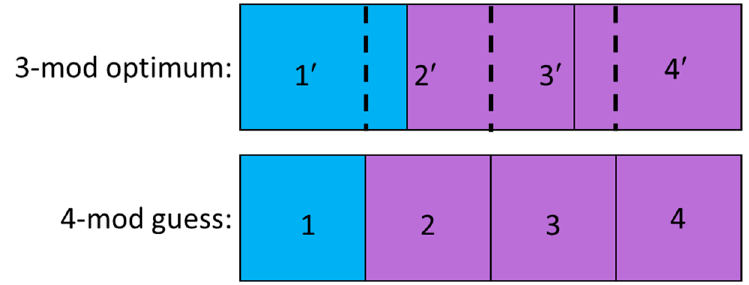
Figure 17. Comparison of the 3-mod optimal design and the 4-mod guess generated from it. The 3-mod design is split into 4 pseudo-modules to compare their relative permeation and reaction rates.